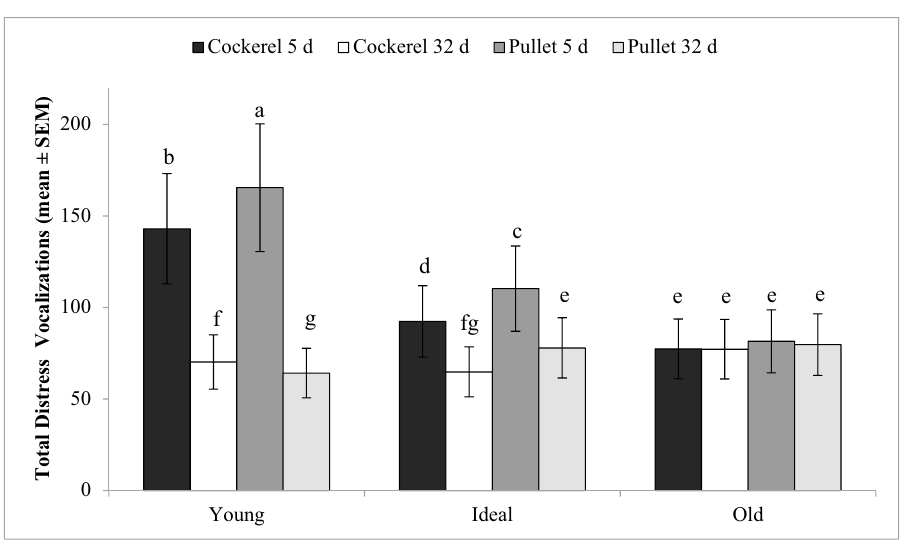
Figure 2. LSMeans ± SEM total distress vocalizations (TDV) of 5 day old and 32 day old cockerels and pullets during the 5-min social isolation test. There was an interaction between maternal age × chick age × sex (P < 0.001). Behavioral differences are indicated by different superscripts (P ≤ 0.002) a–g